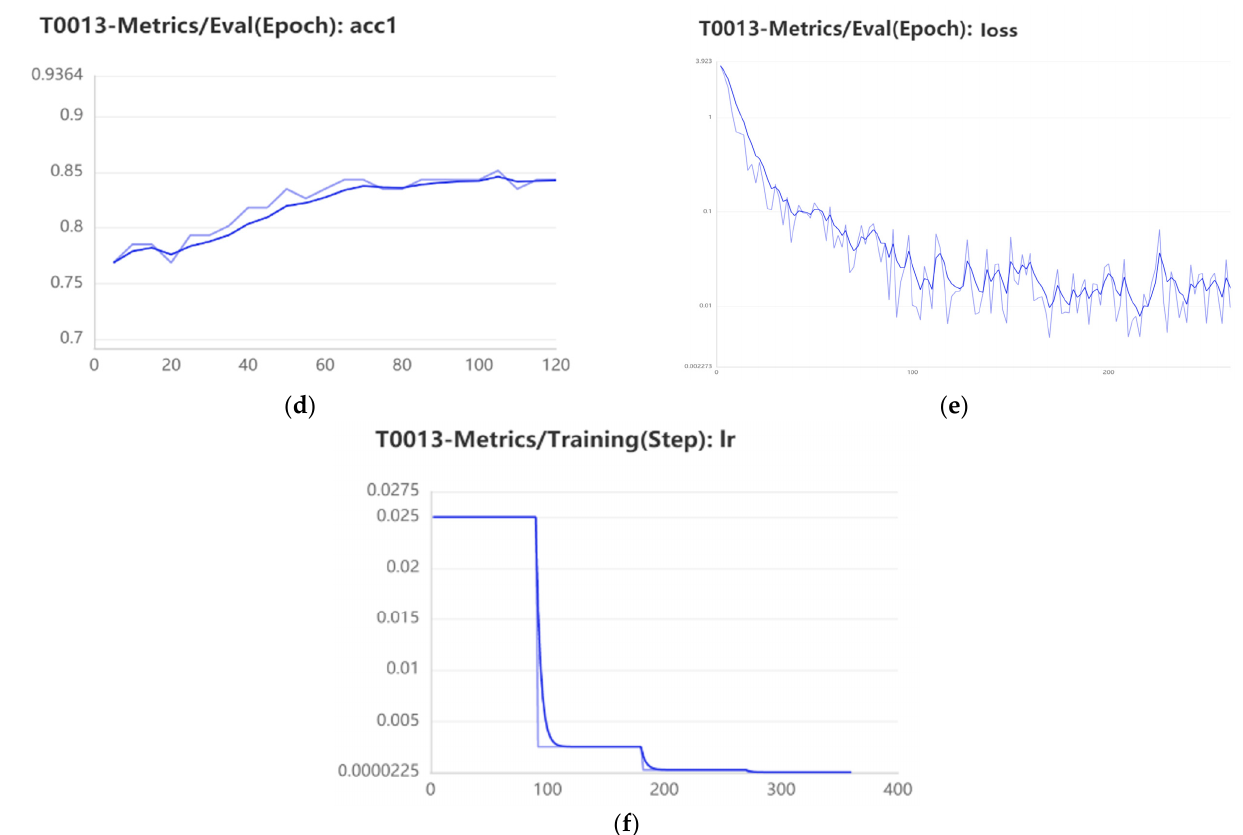
Figure 17. Results of the improved DLC. ( a ) Training and test results; ( b ) X and Y positions in pixels; ( c ) likelihood; ( d ) accuracy of our method; ( e ) loss; ( f ) learning rate.